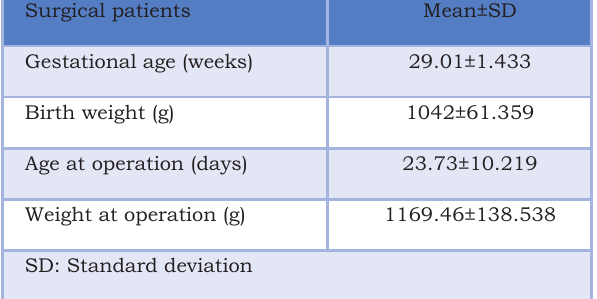
Table 2: Demographics of 26 neonates undergoing operation Surgical patients Mean±SD